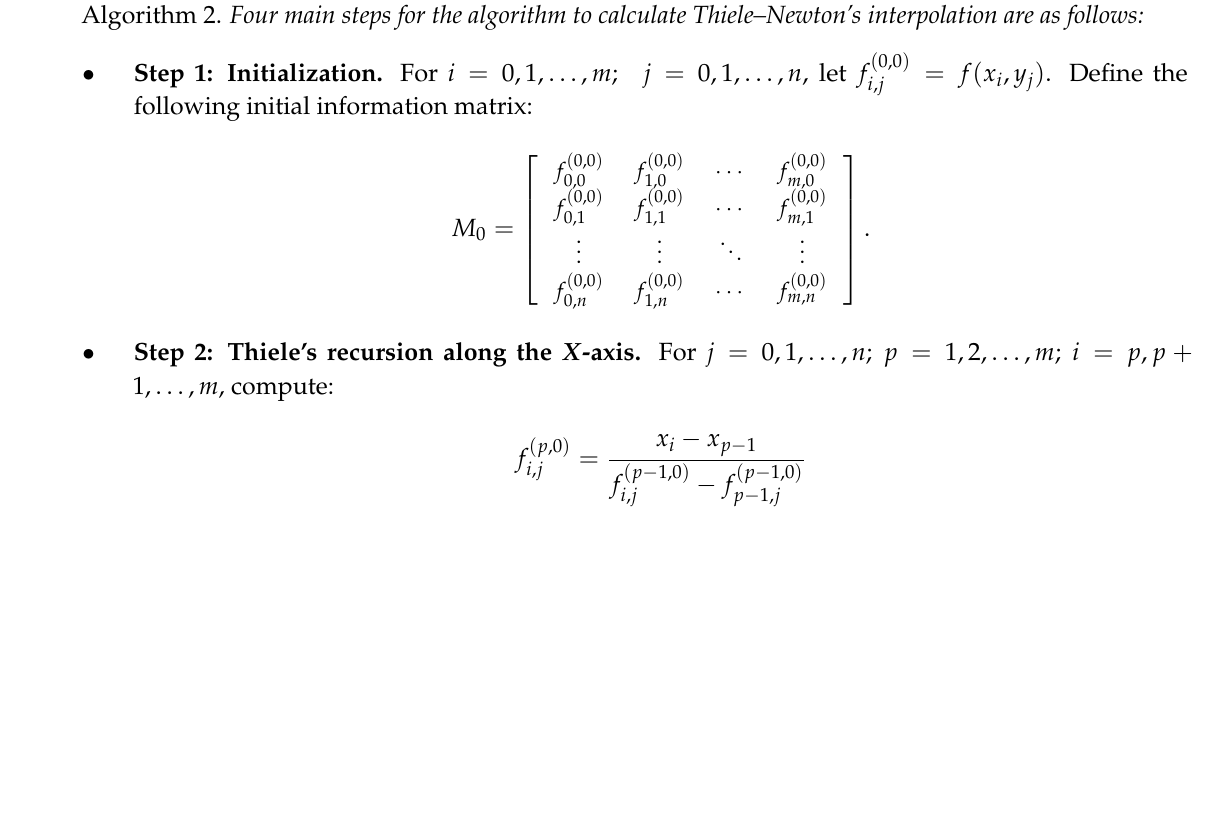
Algorithm 2. Four main steps for the algorithm to calculate Thiele–Newton’s interpolation are as